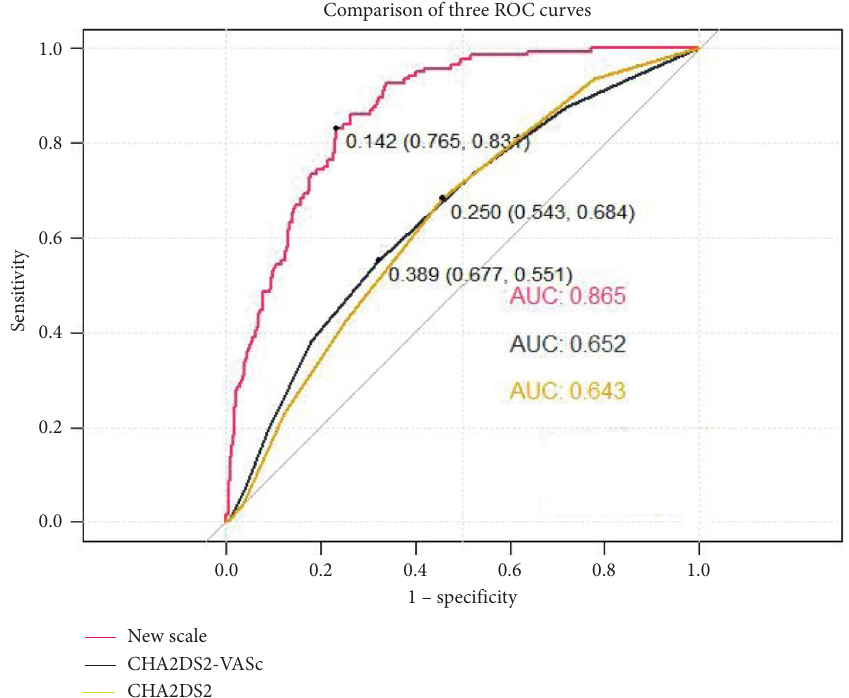
Figure 4: ROC curves, AUC, and an optimal cut-of value of the three scoring systems.